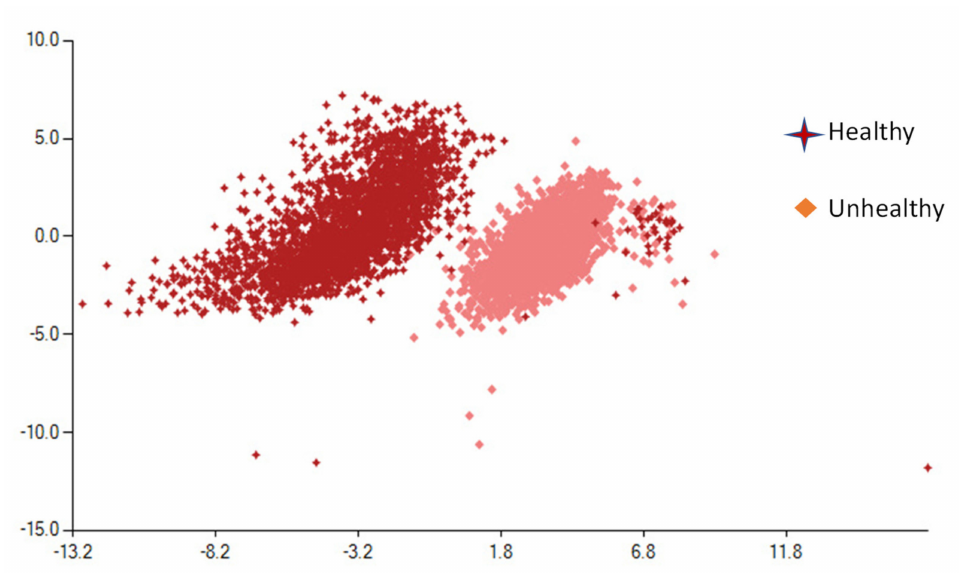
Figure 13. Feature distribution map of the third machine